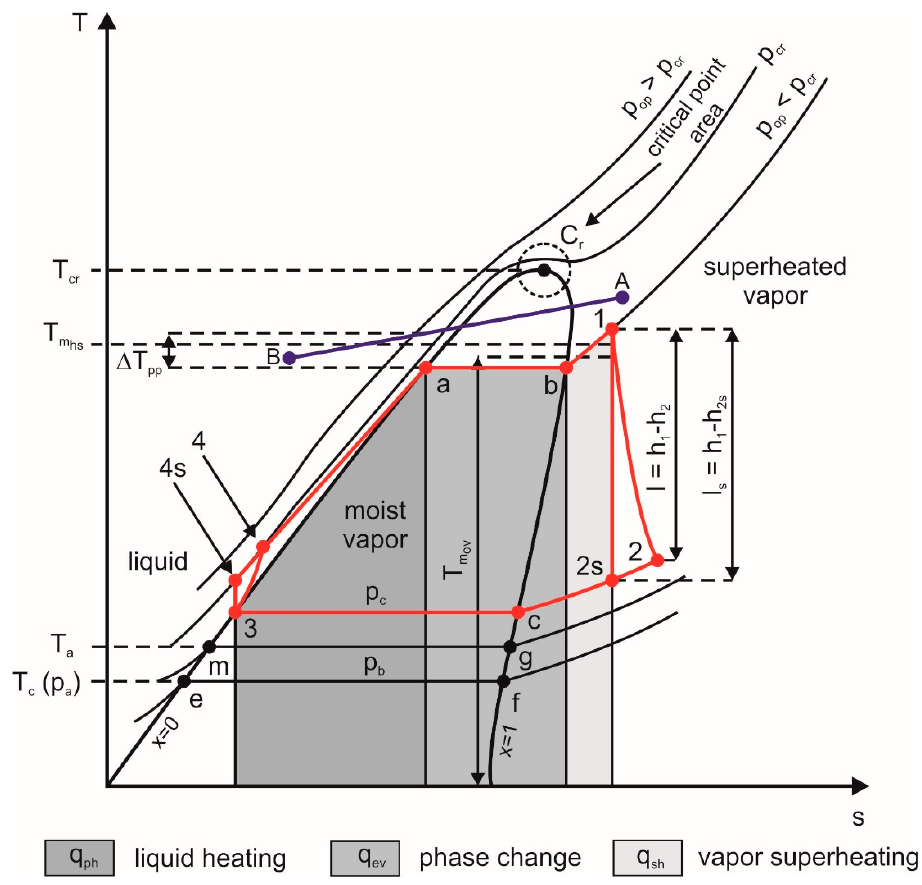
Figure 1. T–s diagram of a low-boiling working fluid.